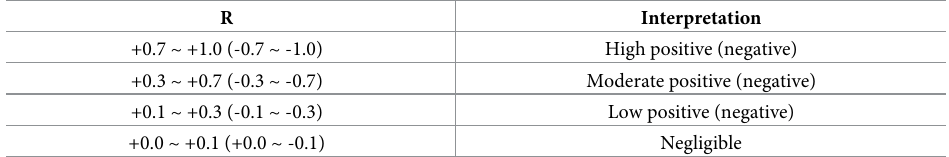
Table 5. Interpretation of the Pearson correlation coefficient